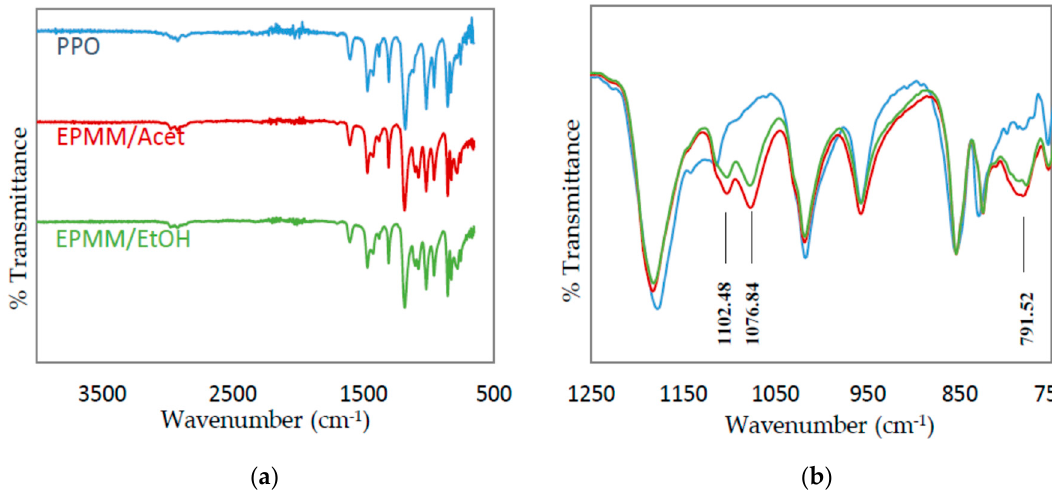
Figure 7. FTIR absorption spectra of the reference PPO, and EPMM/Acet and EPMM/EtOH membranes. ( a ) the entire spectrum; ( b ) the focused spectrum in 1250–750 cm − 1 wavenumber range.